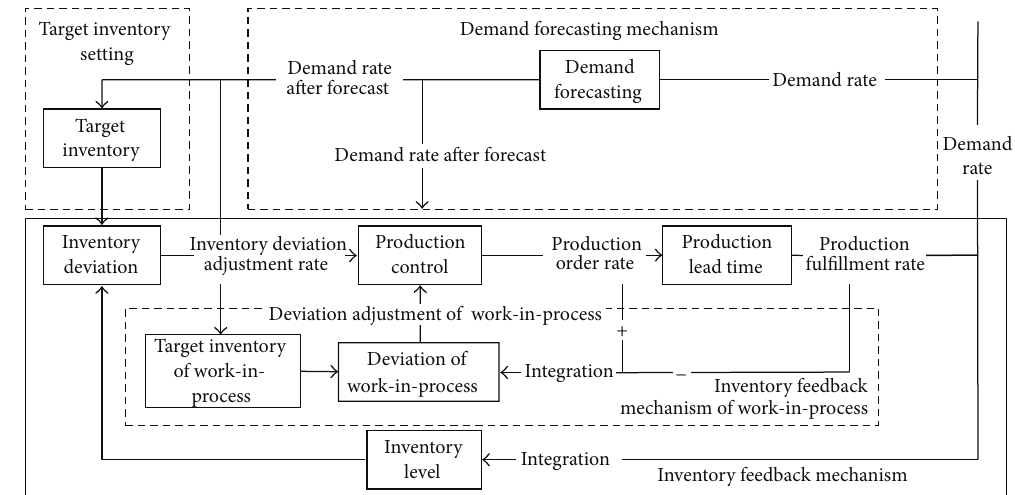
Figure 3: The main parts of expanded IOBPCS